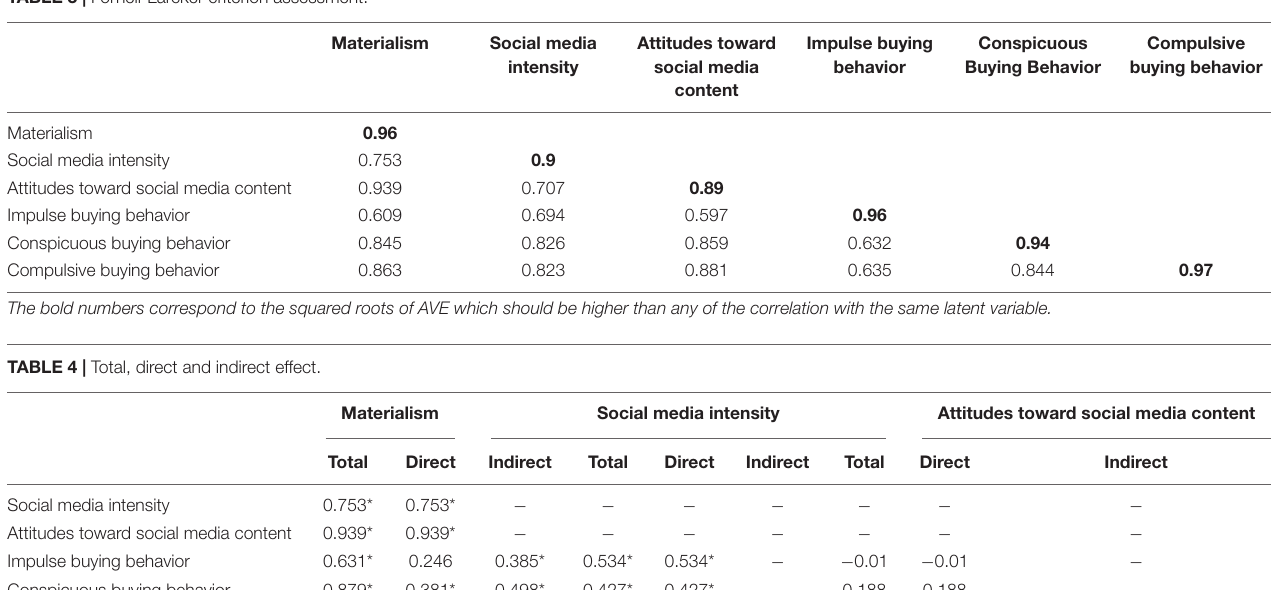
TABLE 3 | Fornell-Larcker criterion assessment.